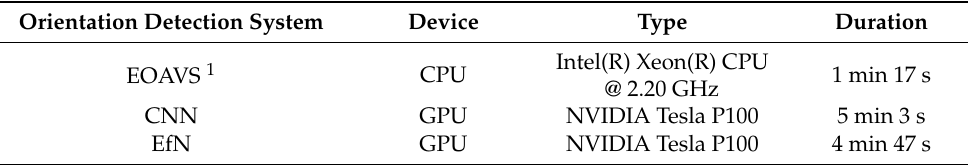
Table 5. Device and duration of orientation detection